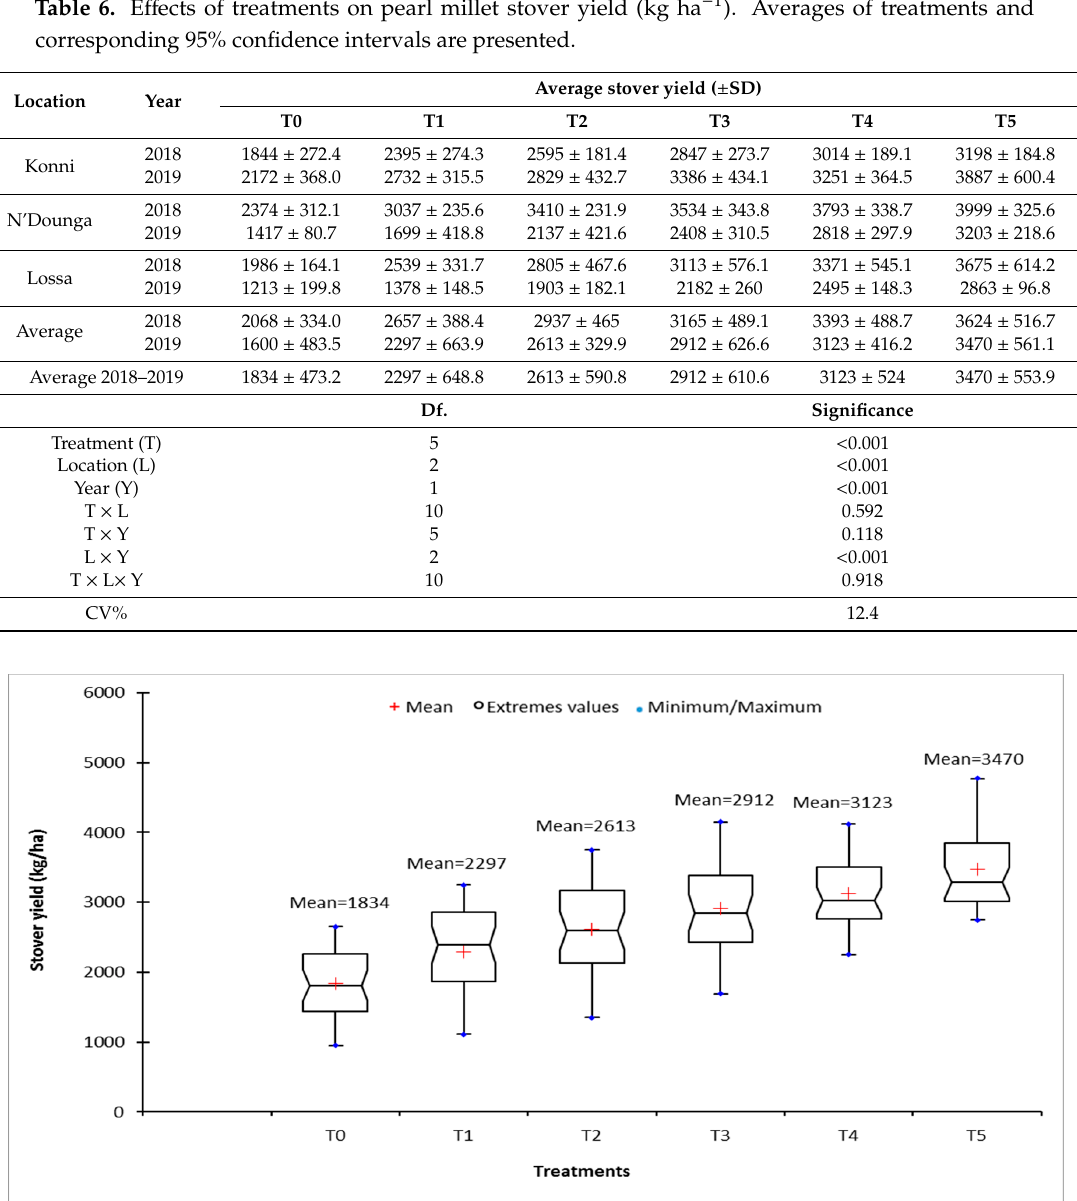
Figure 5. Effects of the treatments on stover yield (kg ha − 1 ) across three sites over two years in the on-station experiments.